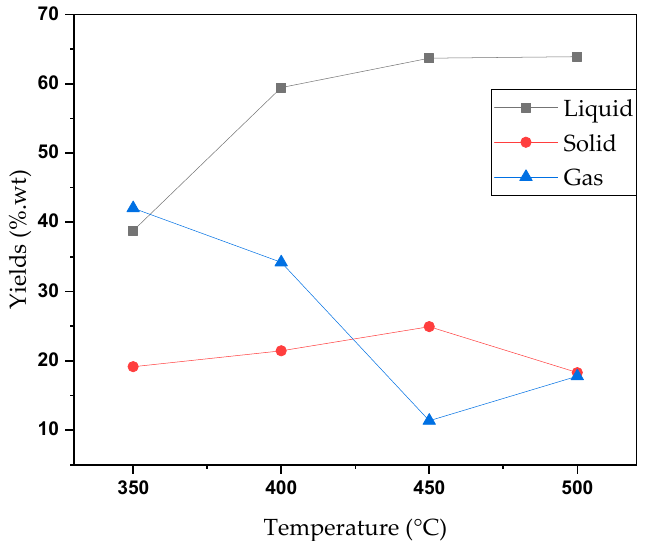
Figure 11. Effect of temperature on yields of products obtained through thermal cracking of WEEE plastics.